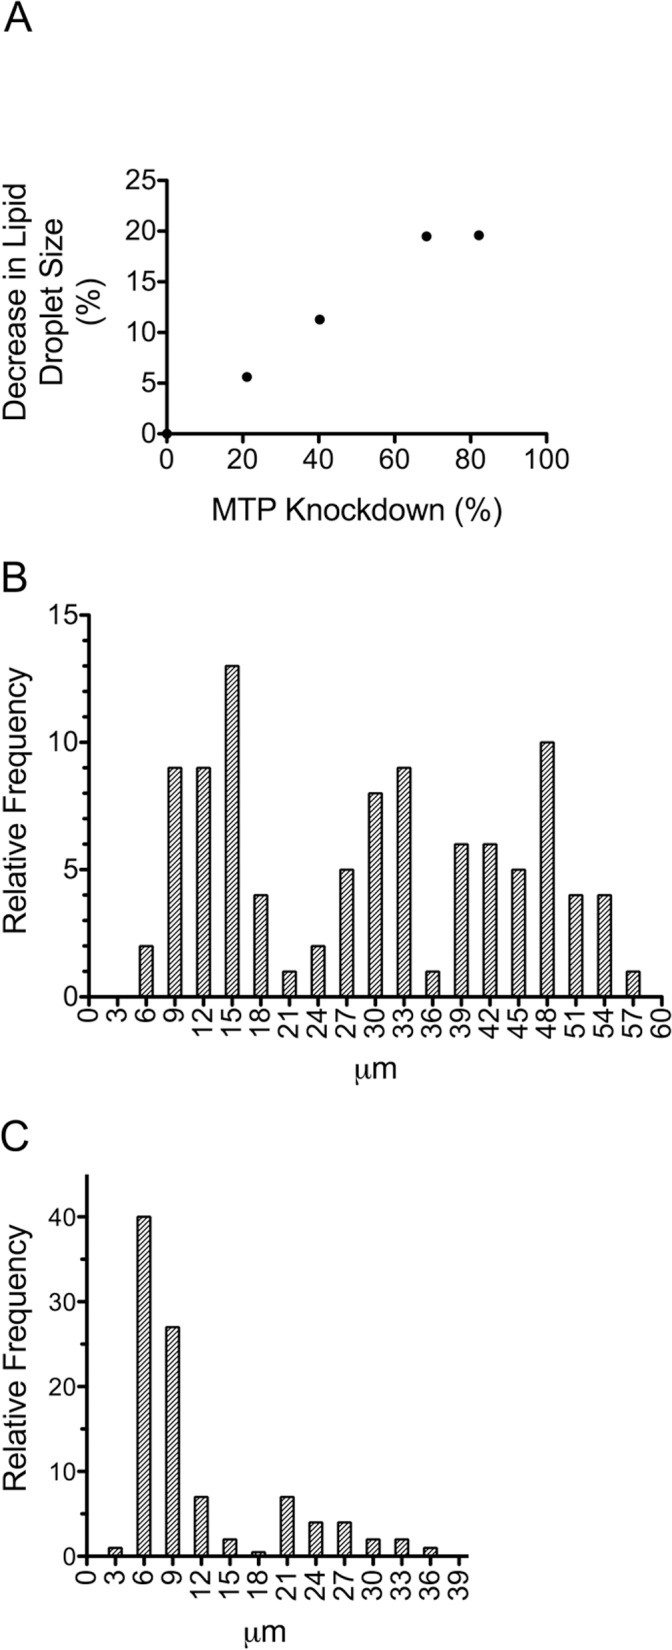
Effects of MTP knockdown on lipid droplet size and distribution.(A) Lipid droplet size in white fat from control and knockdown mice was determined as described in Fig 5. The decrease in lipid droplet size (%) in MTP knockdown mice compared with control was calculated and plotted versus MTP knockdown (%). (B,C) Size distribution of lipid droplets in brown fat from control (B) and knockdown (C) mice. Raw data from Fig 5 were used in this analysis.